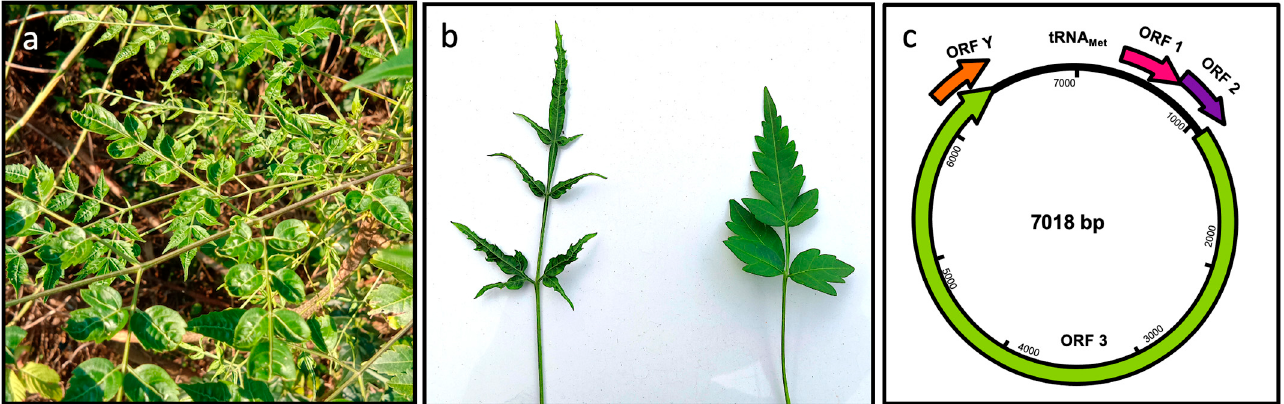
Figure 1. Symptoms of leaf of ChTBV1. ( a ) Leaf deformation observed on a young diseased Chinaberry tree. ( b ) left: Individual leaf showing leaf deformation associated with the presence of ChTBV1. right: typical asymptomatic leaf collected as a negative control. ( c ) Map of the circular dsDNA genome of ChTBV1. Arrows indicate the predicted open reading frames (ORFs).